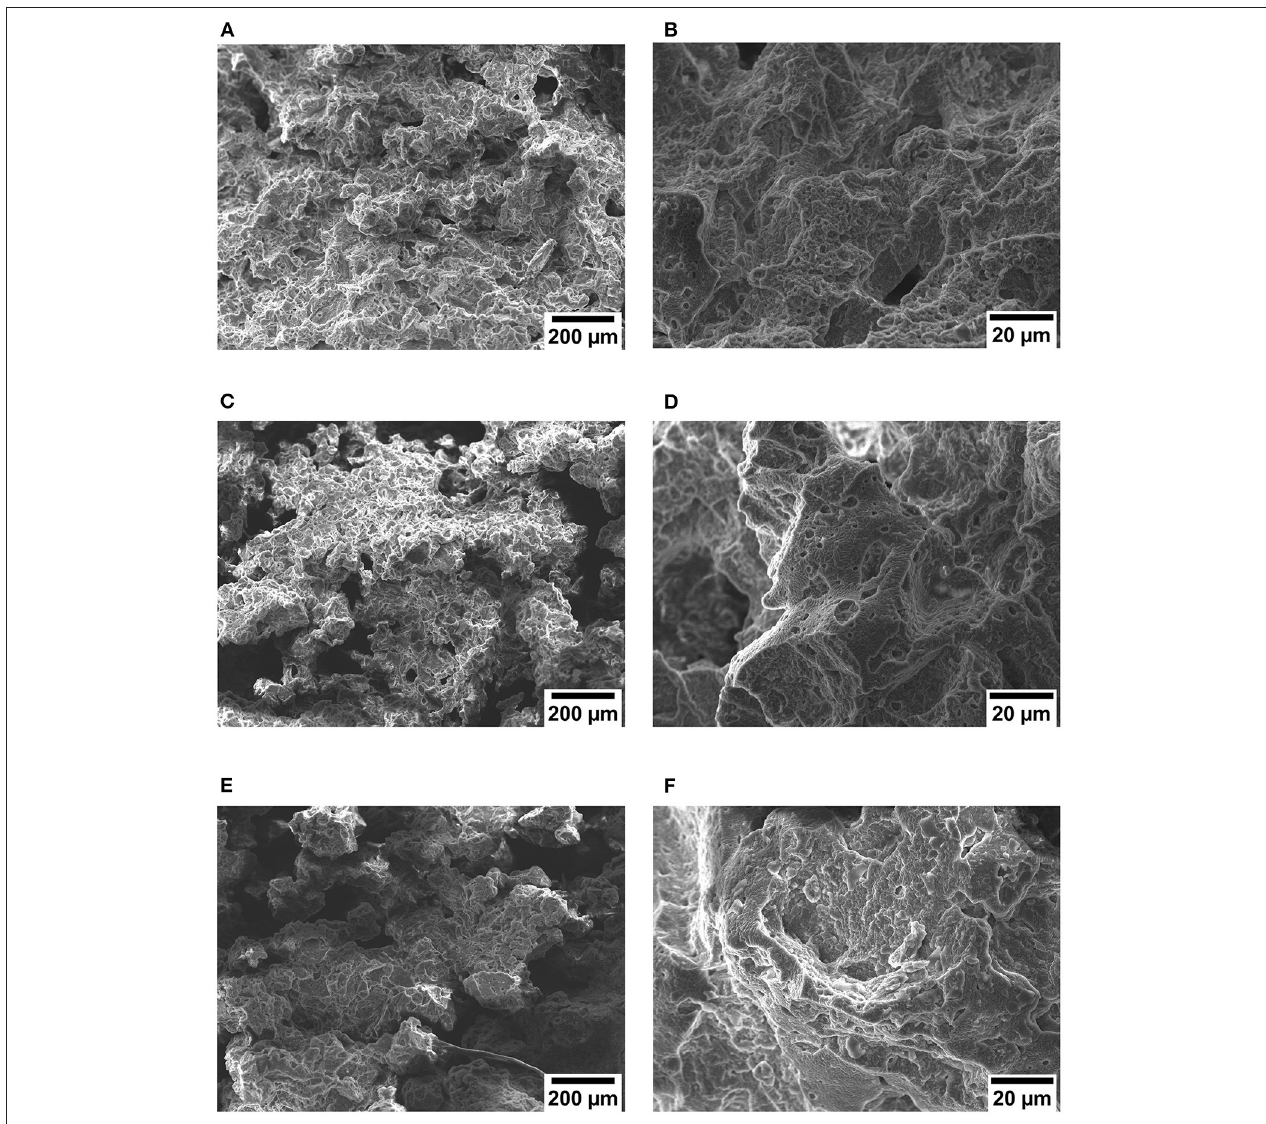
FIGURE 2 | Scanning electron microscope (SEM) micrographs of the prepared TES-EPDM foams at a defined magnification: (A) NaCl 80-100_PCM (100x), (B) NaCl 80-100_PCM (1000x), (C) NaCl 60-80_PCM (100x), (D) NaCl 60-80_PCM (1000x), (E) NaCl 50/50_PCM (100x), and (F) NaCl 50/50_PCM